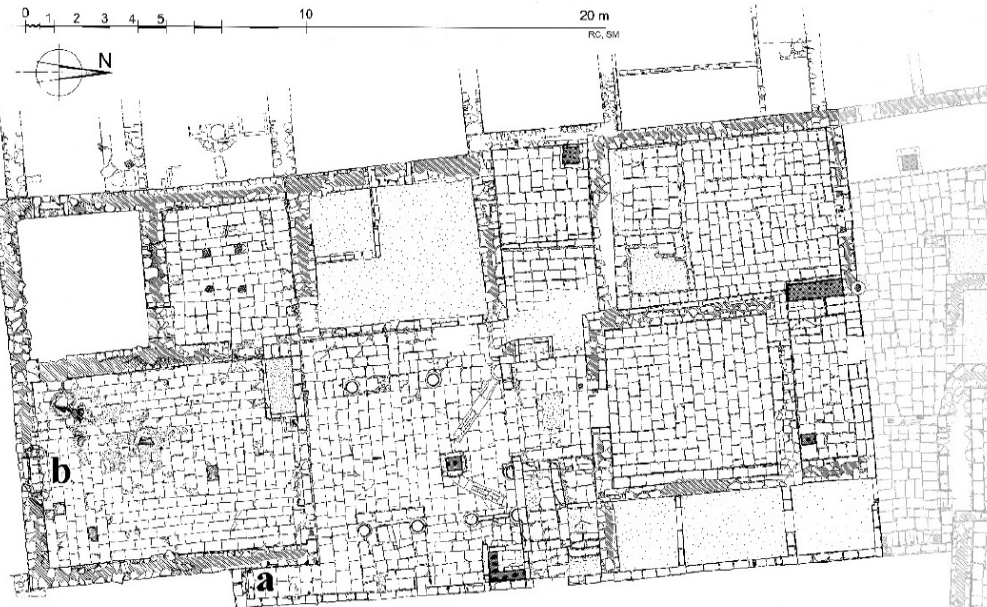
Figure 14. Inventory plan of house H10 with the places marked where figural paintings were found: ( a ) depicting Heron; ( b ) depicting Helios, Harpocrates and Serapis (drawing Rafał Czerner and Stanisław Medeksza).